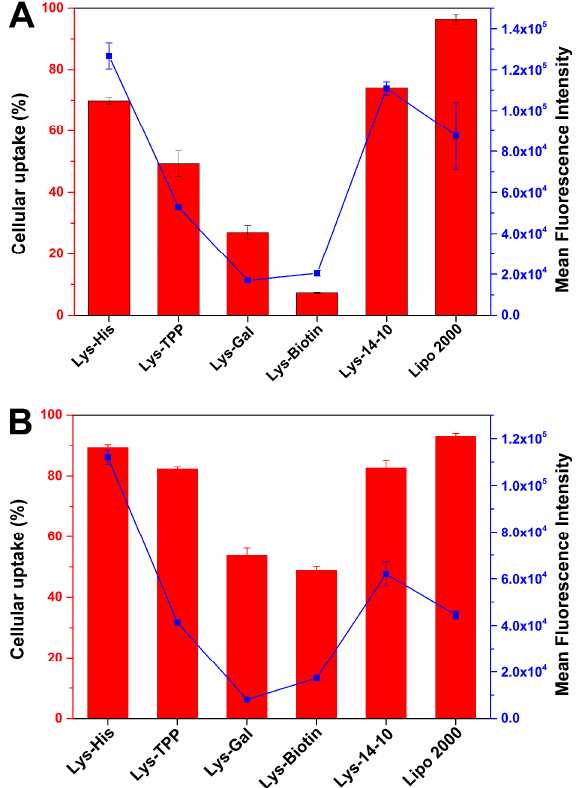
Figure 5. The uptake cell percentage (columns, Cy5-positive cells) and mean fluorescence intensity (dots and lines) of bolaplexes at the optimal N/P ratio in HEK 293 ( A ) and HeLa ( B ) cells quantified by flow cytometry. Lipofectamine 2000 was used as the control. Data represent mean ± SD ( n = 3).